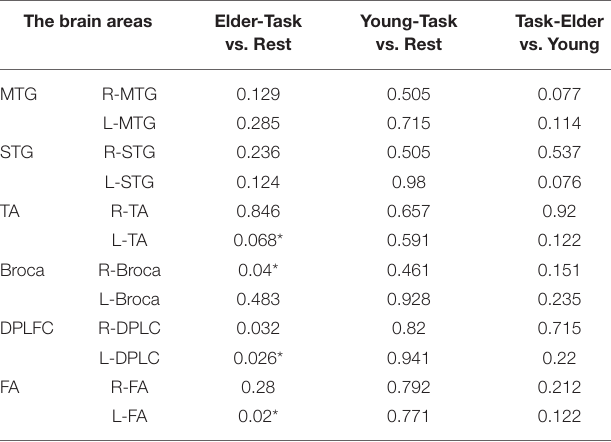
TABLE 1 | The p- values of the comparison between task values and rest values for elder and young people and the p- values of task period between elder and young people (* p < 0.05).